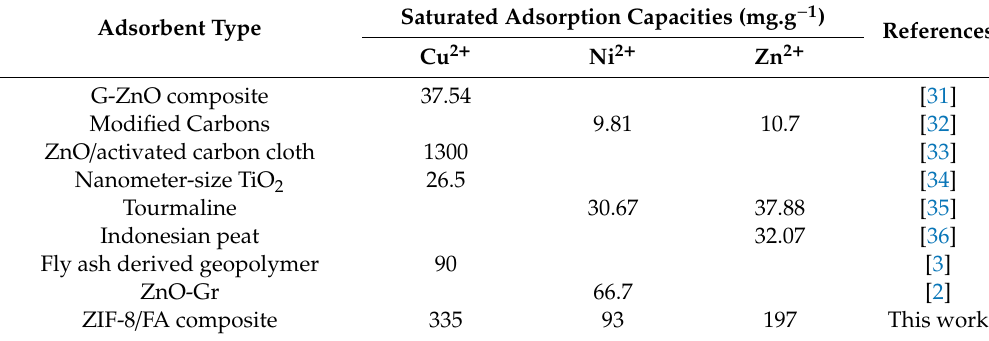
Table 2. Comparison of adsorption capacities (mg·g − 1) of heavy metal ions using different adsorbents.